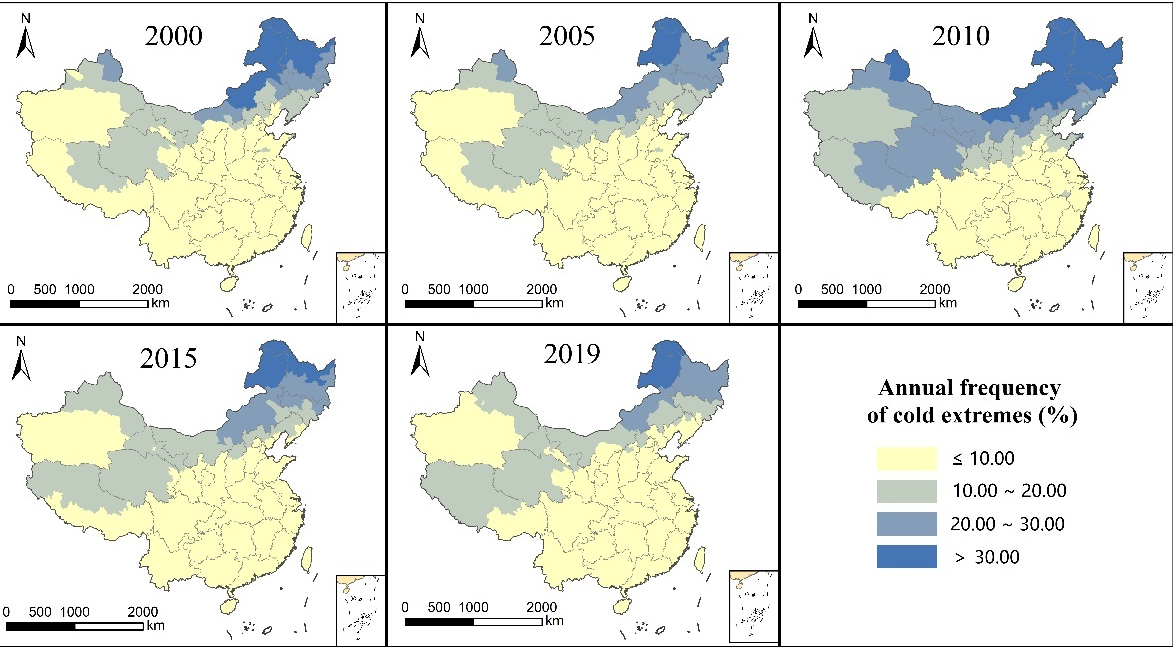
Figure 5. Annual frequency distribution of cold extremes in China from 2000 to 2020.